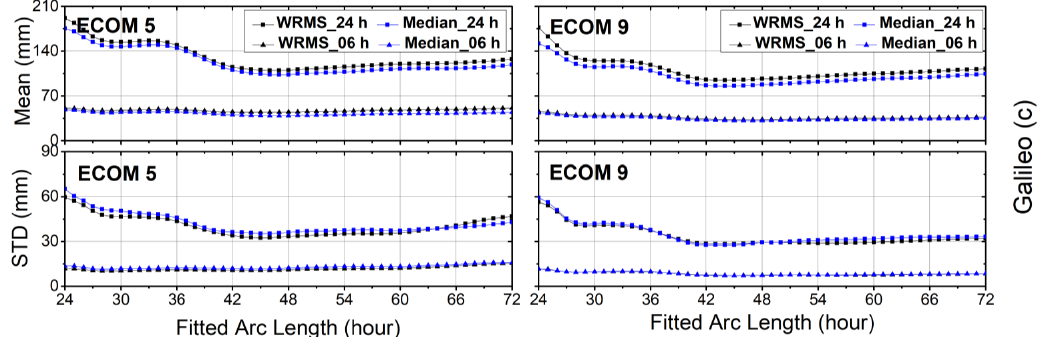
Figure 6. The means and standard deviations (STDs) of weighted root-mean-square (WRMS) and